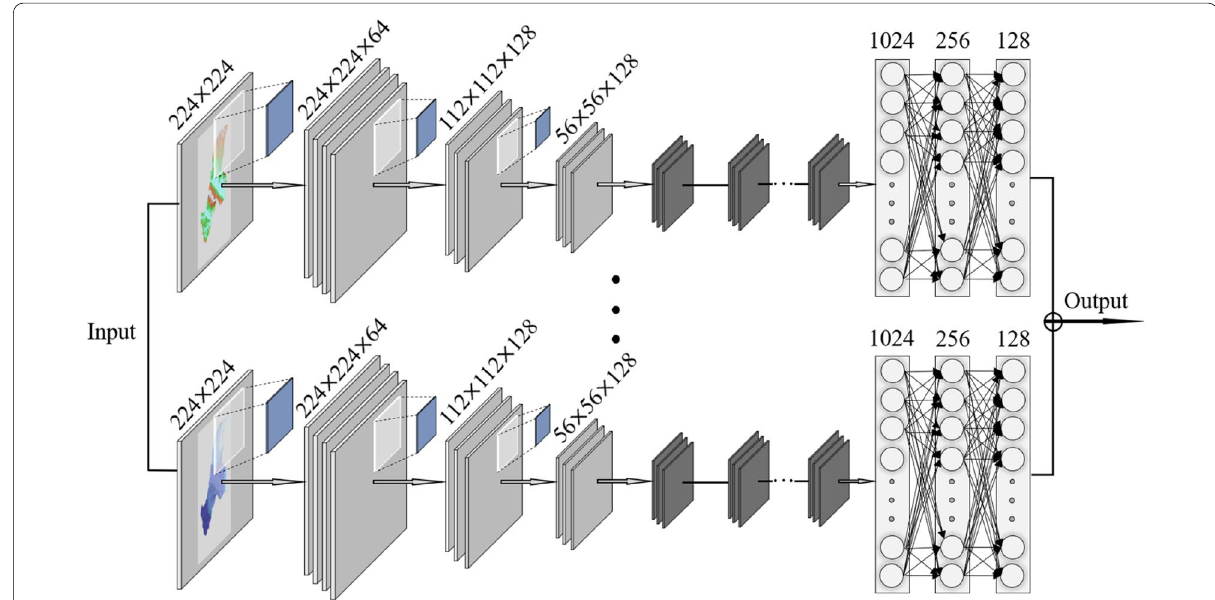
Fig. 4 The structure schematic diagram of landslide net (LSNet)